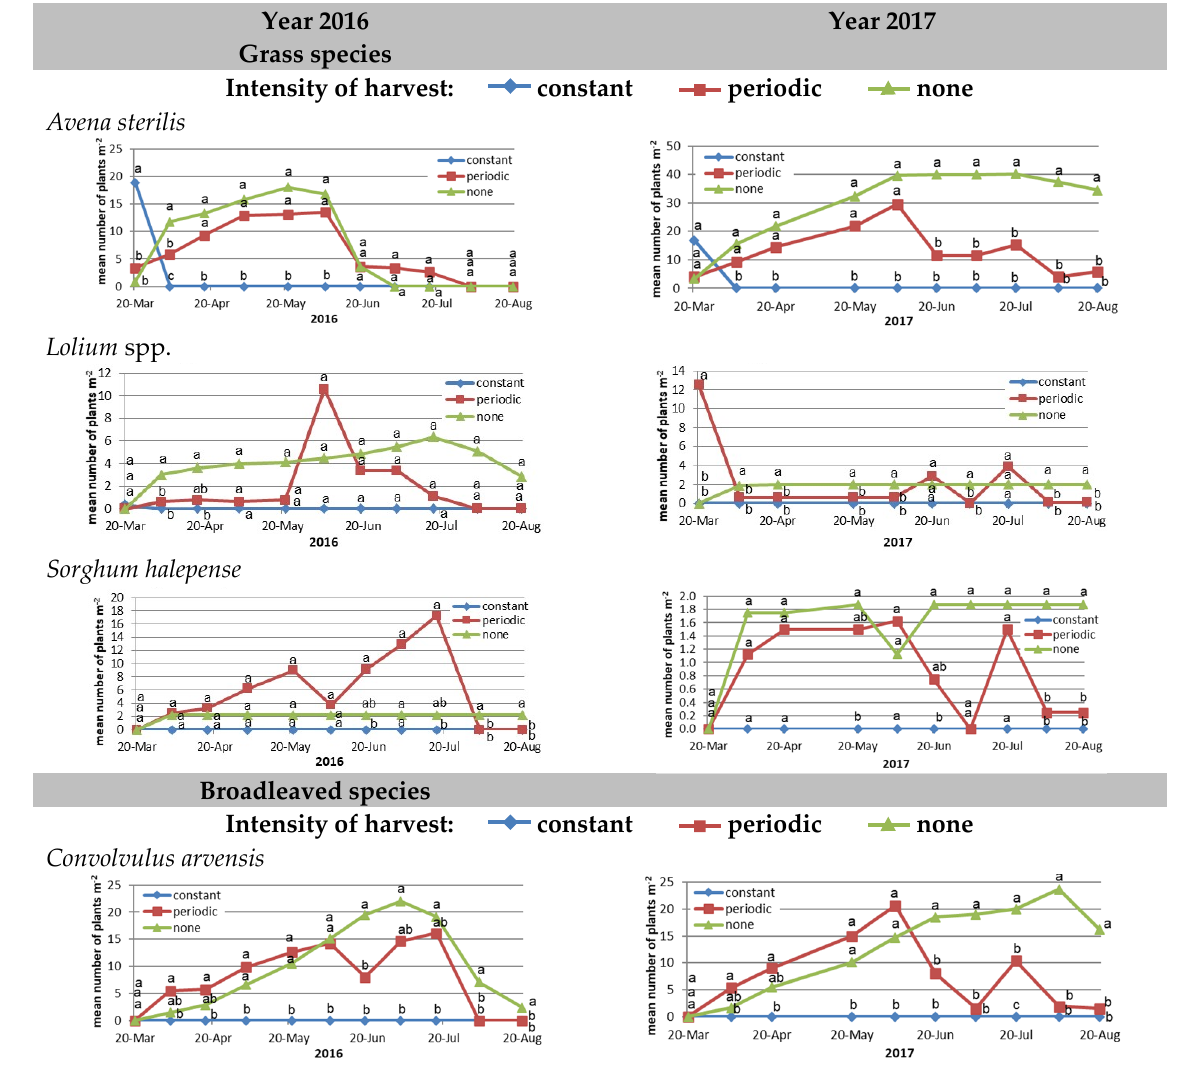
Figure 4. Mean number of plants per m 2 for individual species naturally growing between the rows within the vineyard under different harvest treatments (constant, periodic, or none) during 20 March–20 August in 2016 [49] and 2017. Means in columns not followed by the same letter are significant (Tukey HSD, at p < 0.05, n = 8).